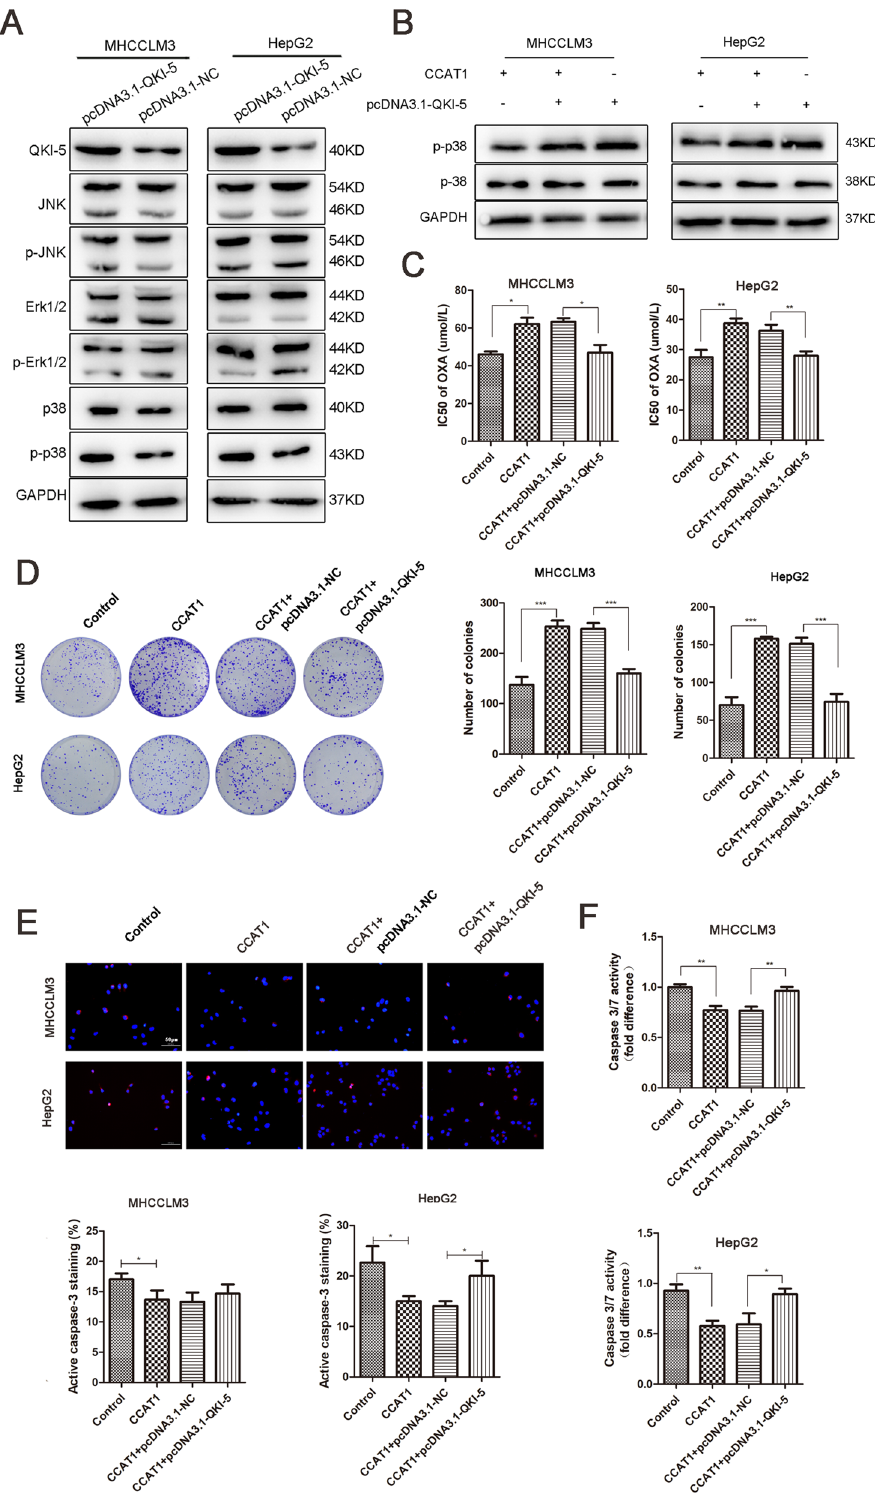
Figure 4. Overexpression of QKI-5 reversed oxaliplatin resistance induced by CCAT1. ( A ) Western blotting analysis of expression levels of QKI-5, JNK, p-JNK, ERK1/2, p-ERK1/2, p38 and p-p38 MAPK in control and pcDNA3.1-QKI-5 cells. ( B ) The phosphorylation and total levels of p38 MAPK in the CCAT1 and QKI-5 overexpression HCC cells. ( C ) IC50 of oxaliplatin was determined when QKI-5 was upregulated. ( D ) The colony formation assay showed that overexpressed QKI-5 significantly attenuated cell proliferation induced by CCAT1 both in HCCLM3 and HepG2 cells. ( E , F ) Fluorescence staining and Caspase-Glo® 3/7 Assay showed caspase-3 activity influenced by CCAT1 and QKI-5. Overexpressed QKI-5 could increase caspase-3 activity reduced by CCAT1. * P < 0.05, ** P < 0.01, *** P <